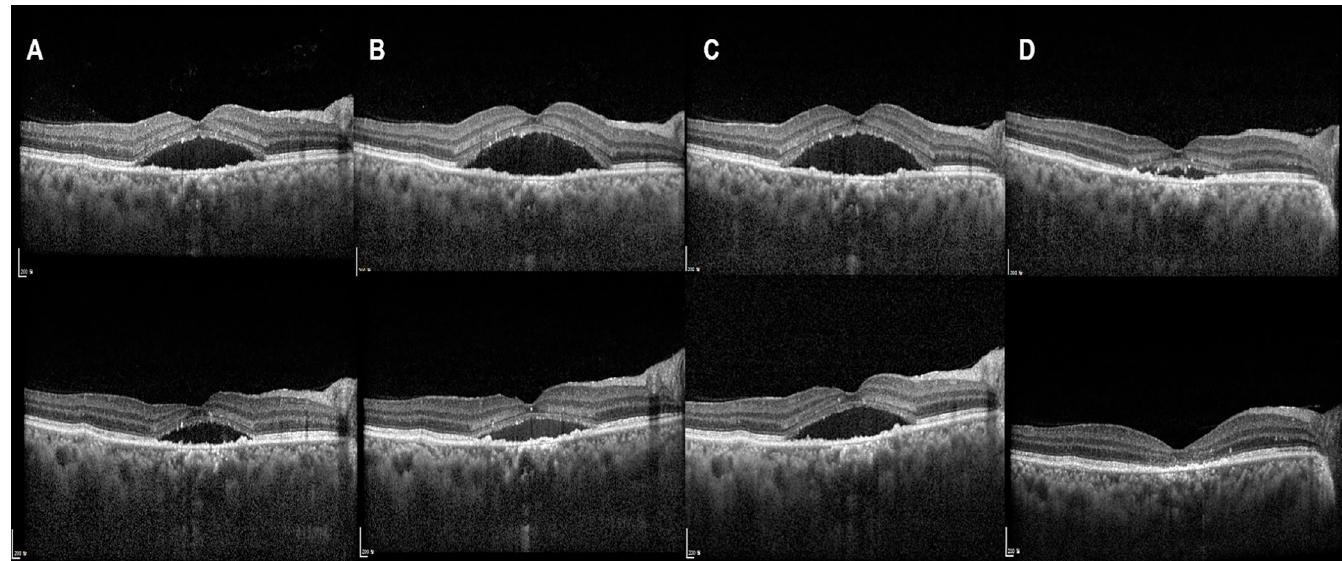
Fig 2. Image from a 49-year-old male patient with central serous chorioretinopathy (CSC) in the right eye. The subretinal fluid (SRF) in the right eye did not resolve after 3 months, and the patient was referred to our hospital. At the time of diagnosis, the best-corrected visual acuity (BCVA) was 0.2 logarithm of the minimum angle of resolution (logMAR) in the right eye. (A) Subretinal fluid (SRF) with retinal pigment epithelium humps and focal photoreceptor ellipsoid zone disruption was noted. Intravitreal bevacizumab injection (IVBI) was performed, but SRF was aggravated (B). Second IVBI also did not improve SRF (C), however, 3 rd IVBI much improved SRF (D). Subsequent 4 th (E), 5 th (F), 6 th (G) IVBI did not completely resolve SRF, but 7 th IVBI led to complete resolution of SRF, and CSC did not recur for 15 months after last IVBI. The BCVA was 0.3 logMAR at the last visit.